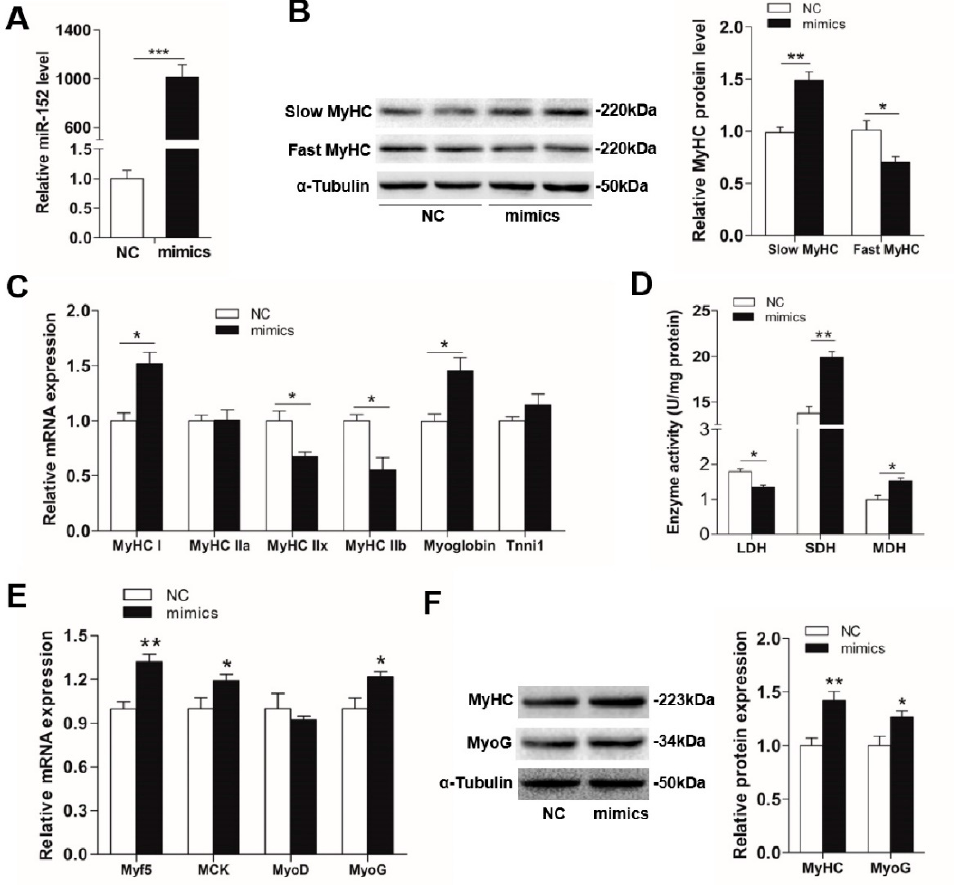
Figure 2. The influences of miR-152 mimics transfection on myofiber specification and skeletal myogenesis. ( A ) The miR-152 level was examined by RT-PCR at four days after transfection. ( B ) The protein expression of MyHC isoforms in porcine myotubes was detected at four days after transfection with miR-152 mimics. α -Tubulin served as an internal control. ( C ) MyHC isoforms and oxidative fiber markers were determined by RT-PCR. ( D ) The activities of metabolic-related enzymes in porcine myotubes transfected with miR-152 mimics. ( E ) Relative mRNA levels of Myf5 , MCK , MyoD , and MyoG were detected by RT-qPCR at four days after miR-152 mimics transfection. ( F ) The protein expression of myogenic markers, MyHC, and MyoG, were detected by western blot at four days after miR-152 mimics transfection and analyzed using image J. Results are presented as mean ± S.E.M. ( n = 4, four independent experiments). * p < 0.05, ** p < 0.01 and *** p < 0.001 when contrasted with the